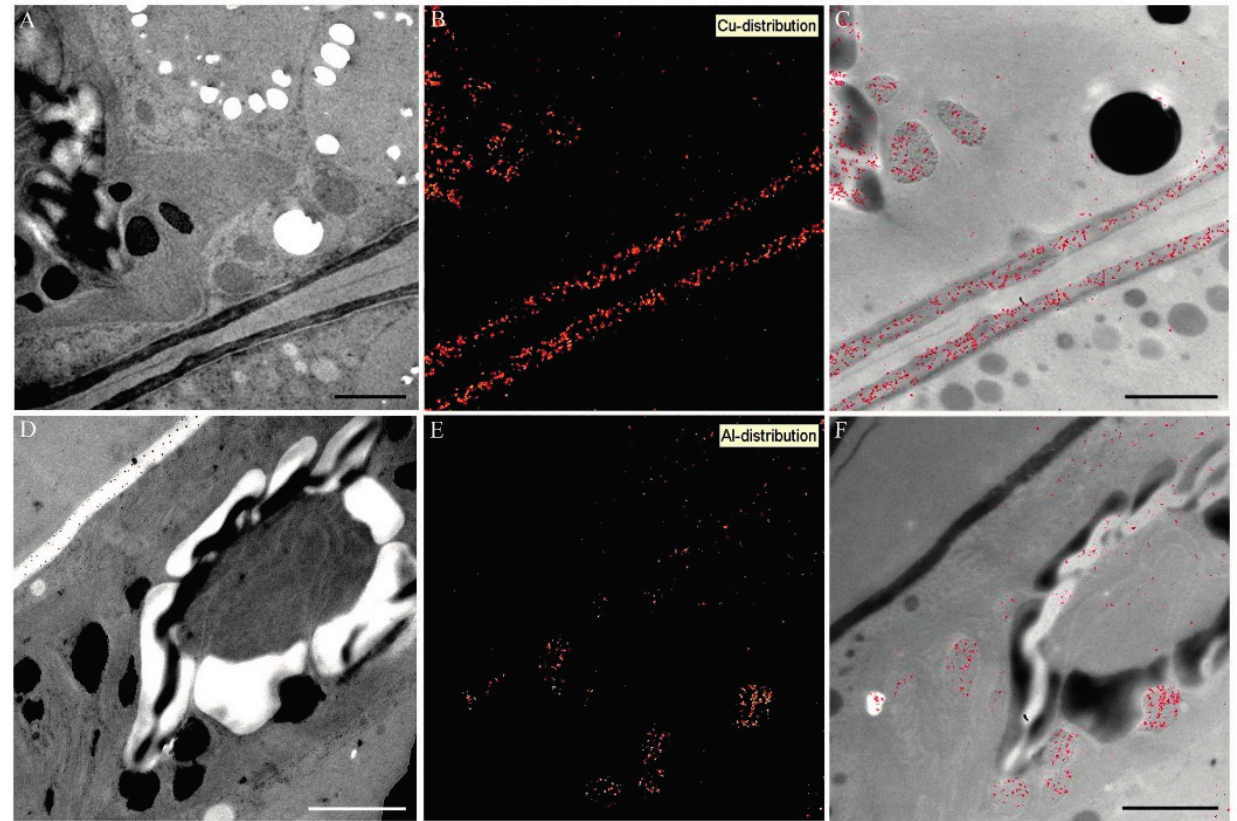
Figure 8. Element distribution visualized by electron spectroscopic imaging (ESI) in Desmidium filaments treated with 0.3 µM CuSO 4 ( A – C ) and 10 µM Al 2 (SO 4 ) 3 ( D – F ) for 21 days; ( A , D ) TEM micrographs of Desmidium cells; ( B , E ) element distribution by ESI in red and ( C , F ) superimposition of TEM images and corresponding element distribution. Bar = 1